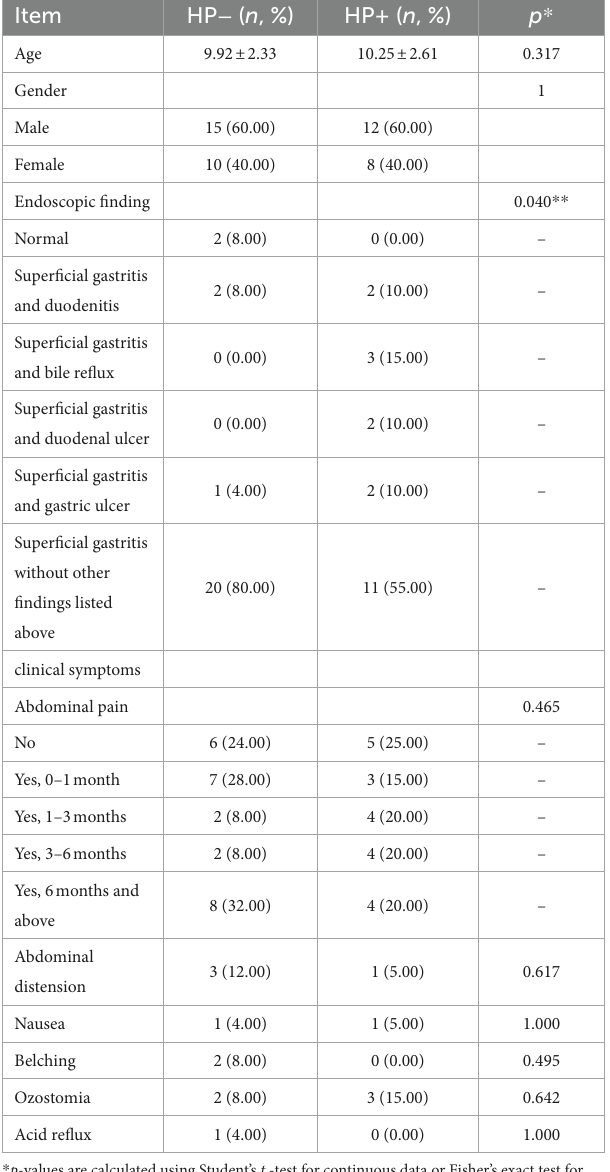
TABLE 1 Demographic and clinical characteristics of HP − and HP+ PCG in the current